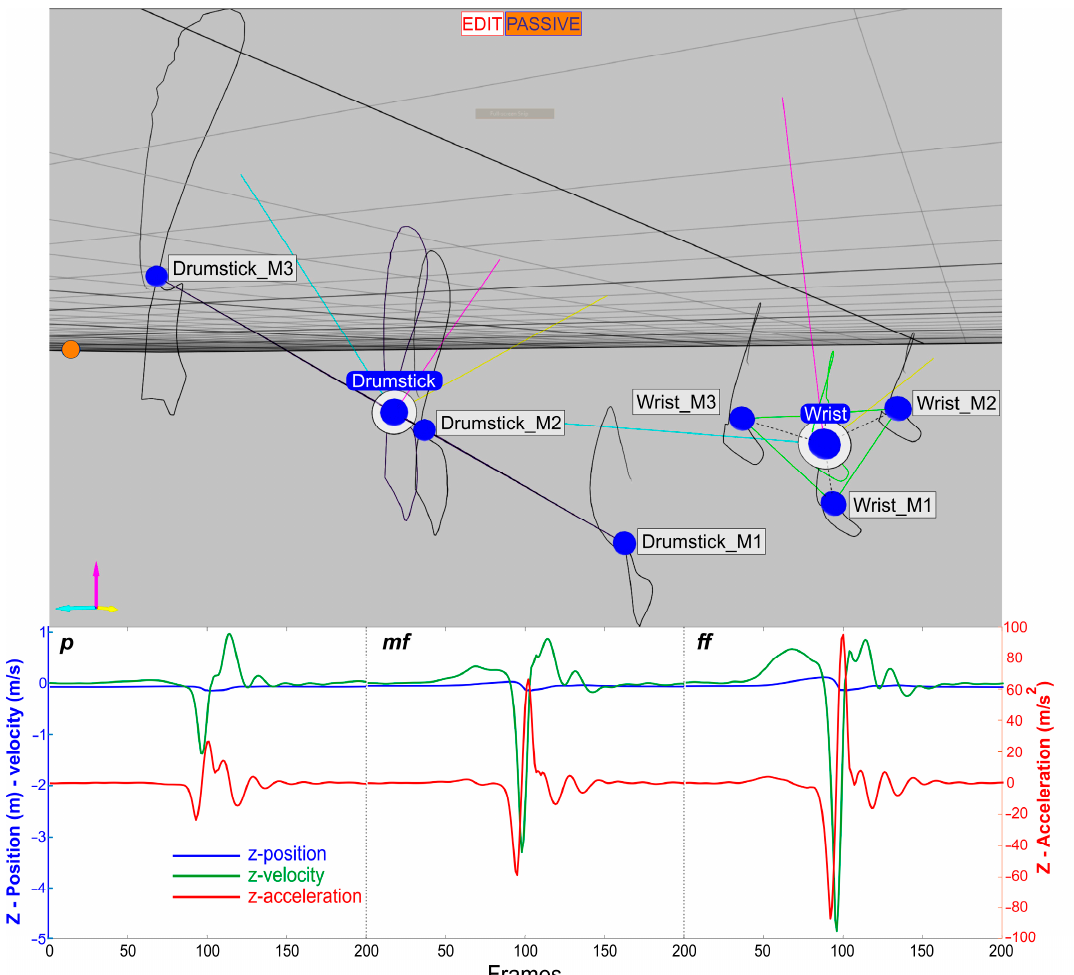
Figure 3. Top: Traces for the ff stroke for all three reflective markers and centroids of rigid bodies. Bottom: Vertical position, velocity, and acceleration of drumstick head for the three representative strokes, p , mf, and ff .